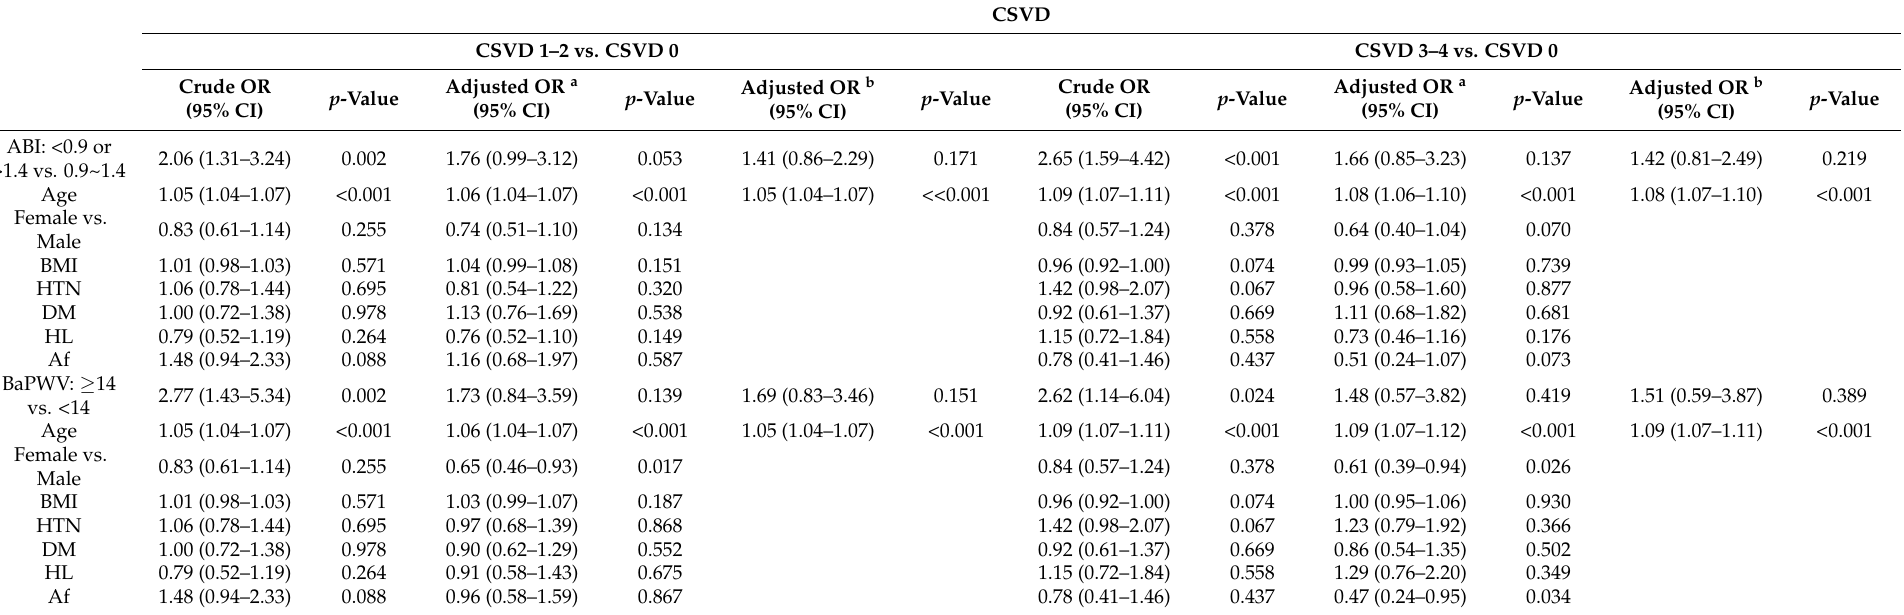
Table 3. Multinomial logistic regression for predictors of